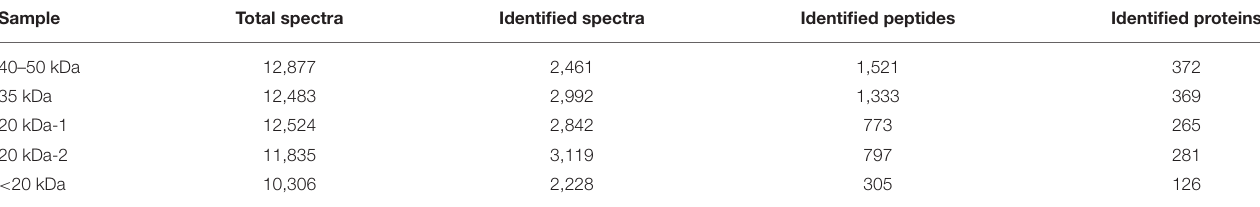
TABLE 1 | Identification results